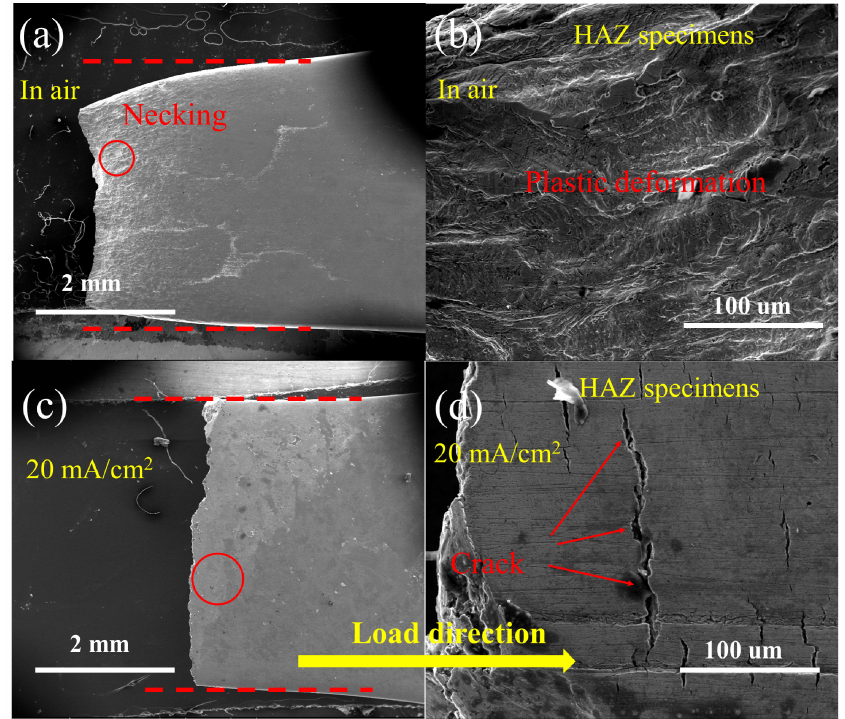
Figure 8. The morphology of the lateral morphologies of the heat-a ff ected zone (HAZ) ( a , b ) in air and ( c,d ) during in situ hydrogen charging at a current density of 20 mA / cm 2